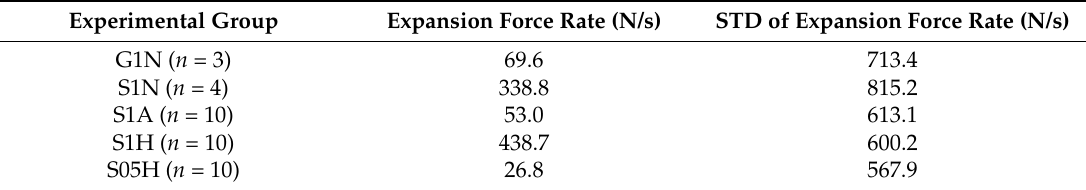
Table 3. Expansion force rate calculated by the average of each expansion force rate profile. Experimental